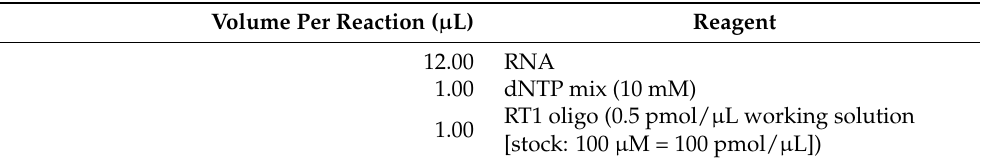
Table 7. RNA-Primer Mix for Reverse